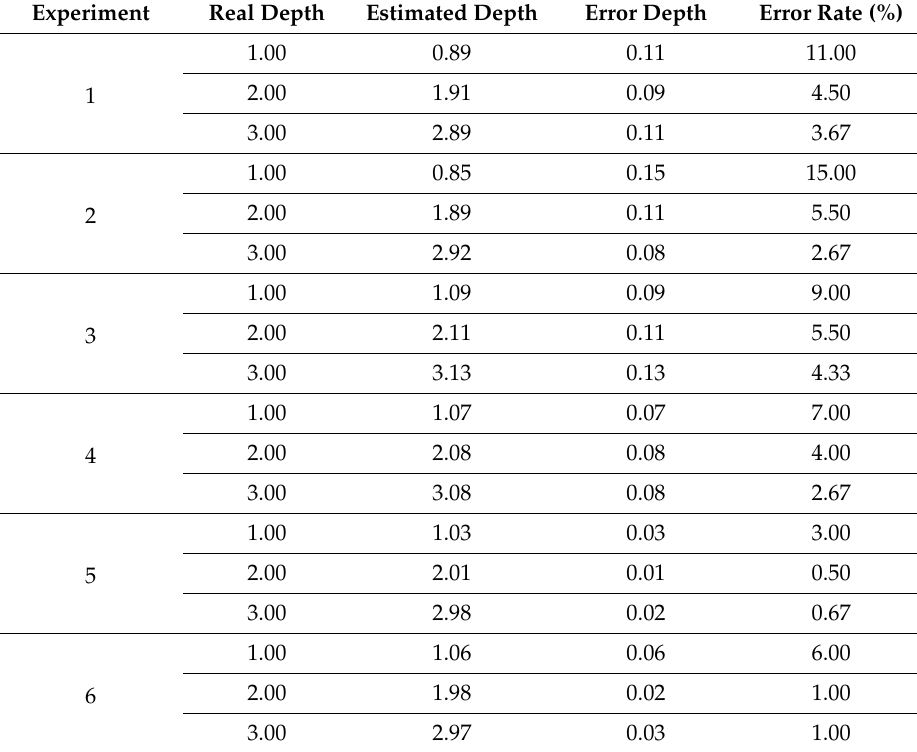
Table 3. Contact depth comparison and error analysis (unit: